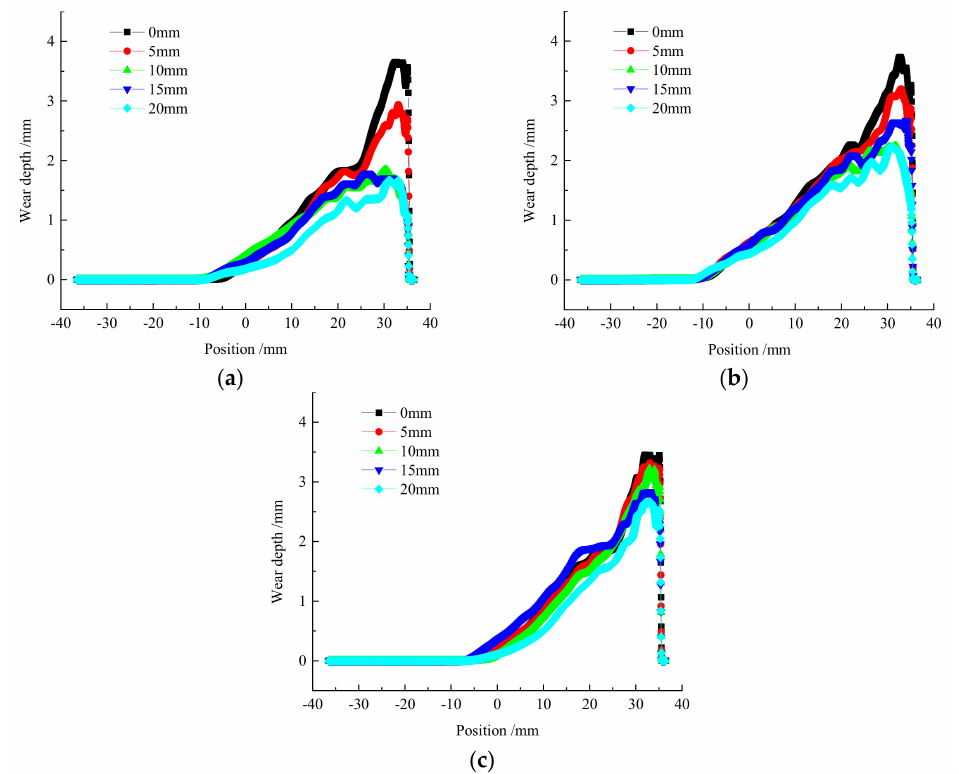
Figure 15. Rail wear area. Radius: ( a ) 350 m; ( b ) 300 m; and ( c ) 250 m.